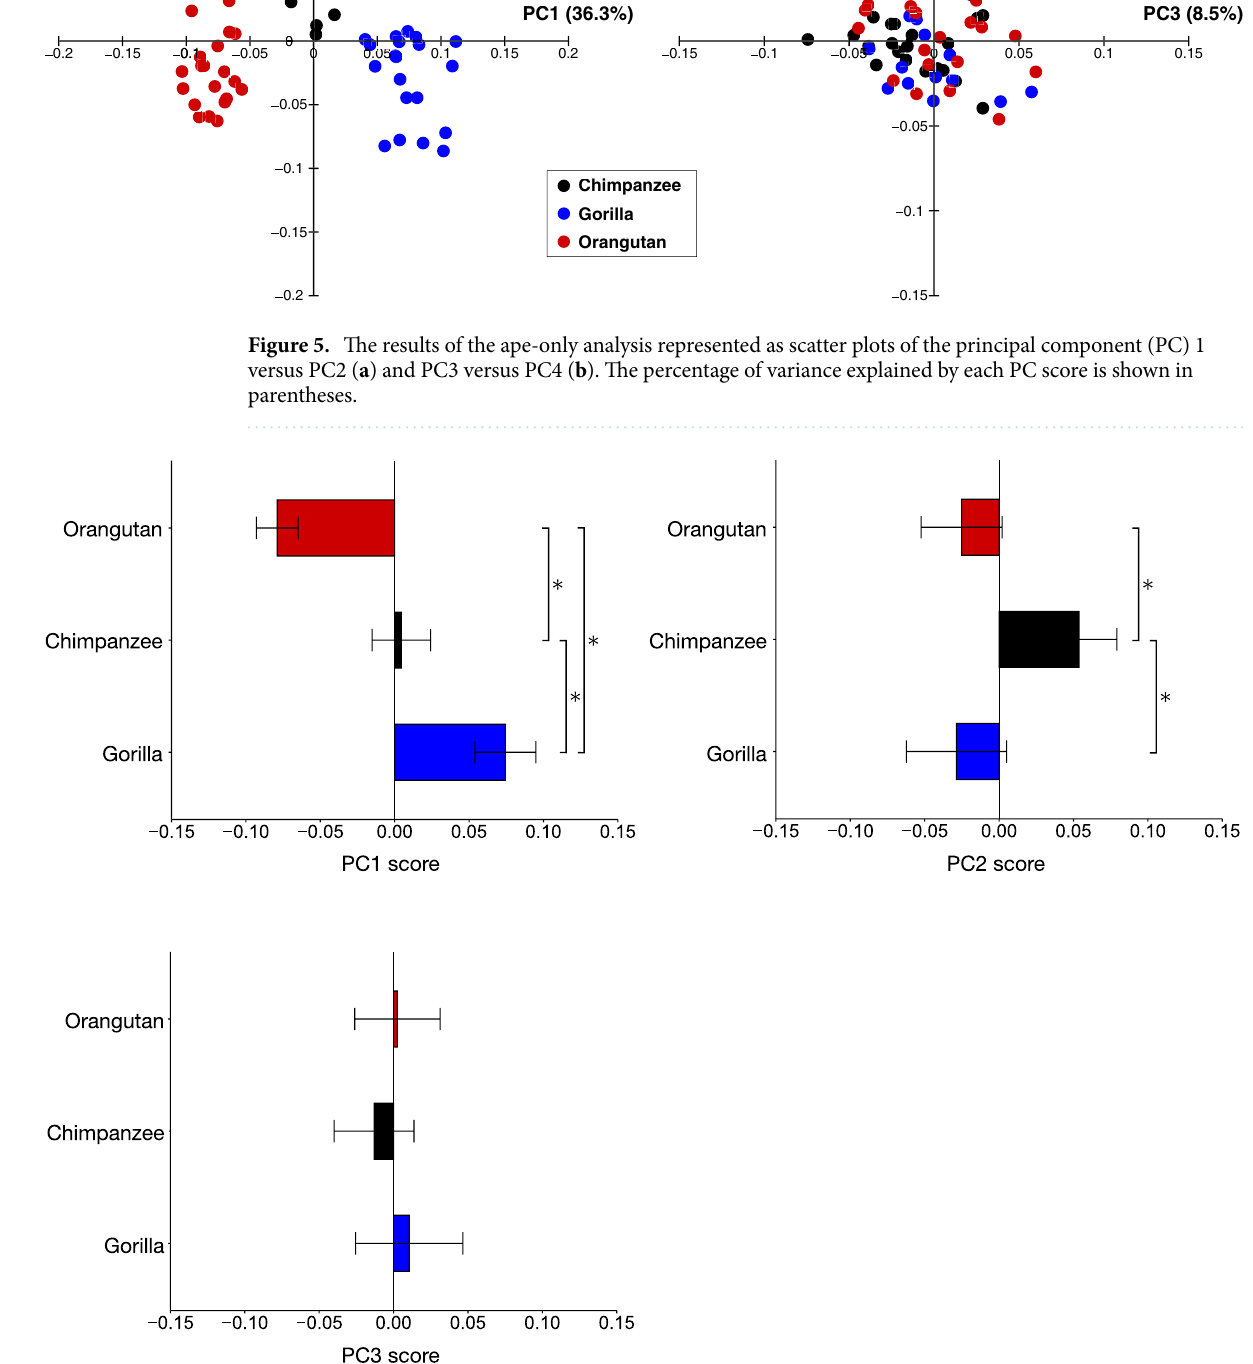
Figure 6. Interspecific differences in the mean principal component scores in the ape-only analysis. The asterisk indicates that there is significant difference in the PC scores among species ( P <